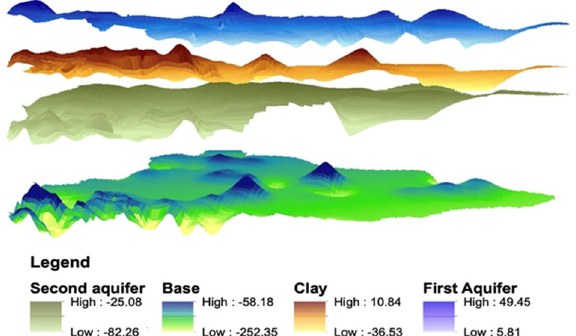
Figure 6. Combined 3D aquifer system of the study area (J.D: sketched this figure with the help of ArcGIS Software, Version 10.0. Redlands, CA: Environmental Systems Research Institute, Inc., 2010, http:// www. esri.